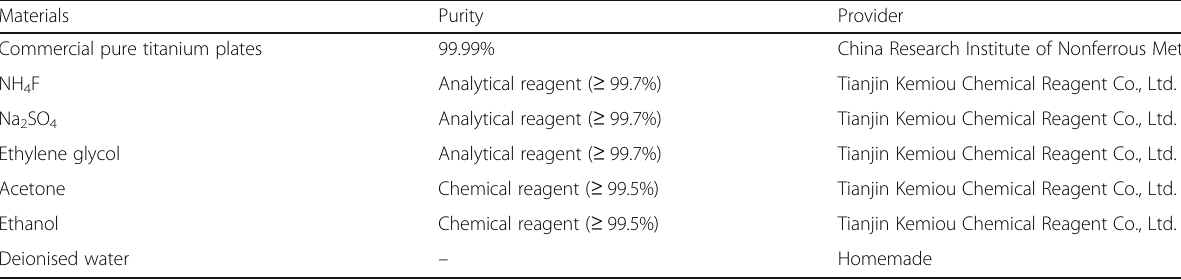
Table 1 Raw materials involved in the